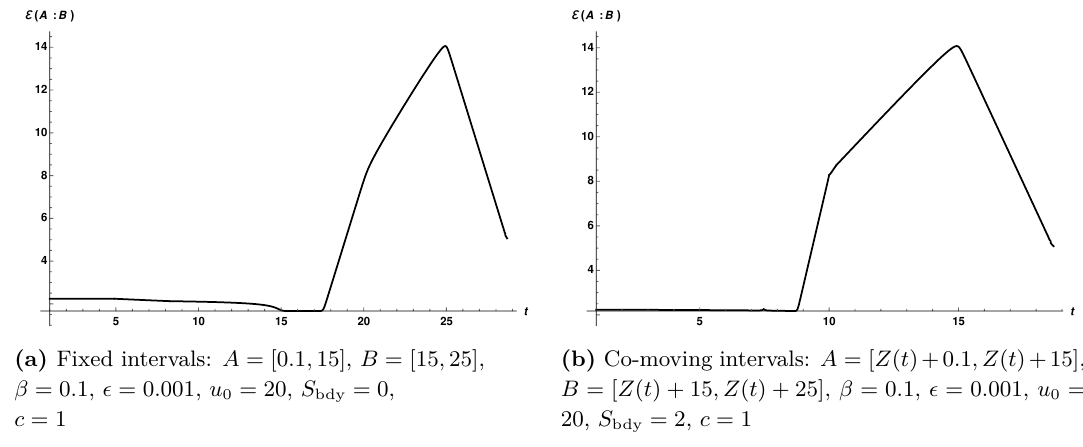
Figure 25. Adjacent intervals. Page curve for the entanglement negativity between two adjacent intervals in a kink mirror BCFT.